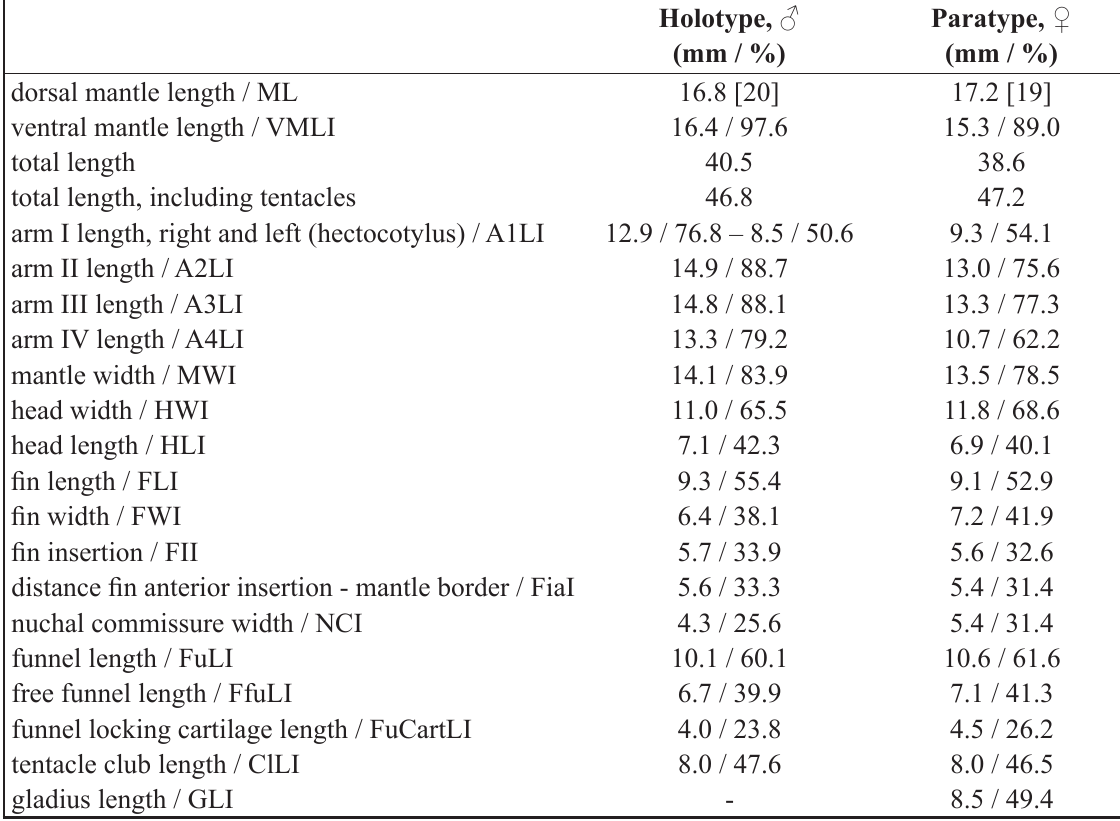
Table 1. Measurements and indices of type specimens of Sepiola boletzkyi sp. nov., MLs in square brackets are those taken on fresh specimens prior